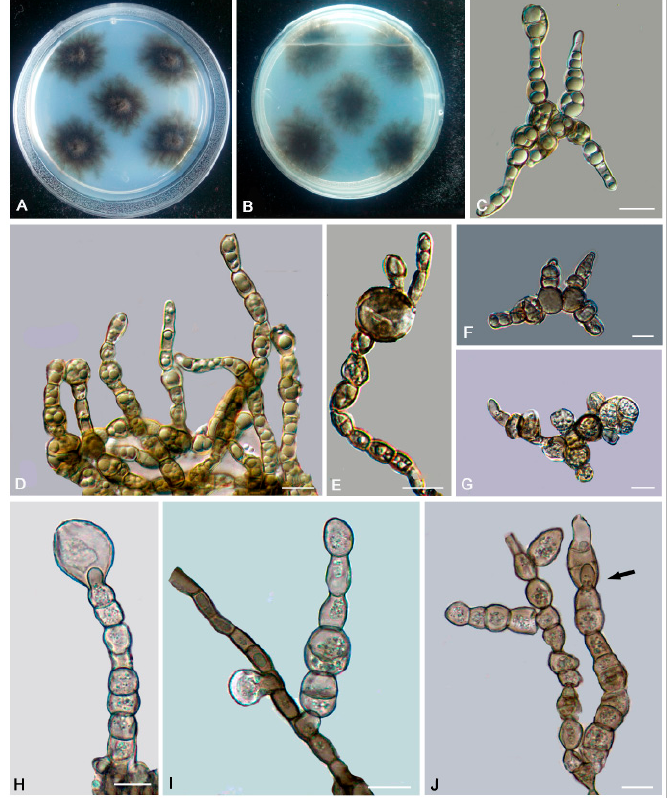
Figure 13. Trichomerium cicatricatum (CGMCC 3.17307). ( A , B ) Colony forward and reverse after 20 weeks on MEA. ( C ) Conidia with 4 arms. ( D – F ) Moniliform hyphae with proliferation at the apex. ( G ) Solitary, enlarged, darkly pigmented multicellular body. ( H – J ) Endoconidia develops within intercalary and terminal cells (arrow). Scale bars: ( C – J ) = 10 μ m.